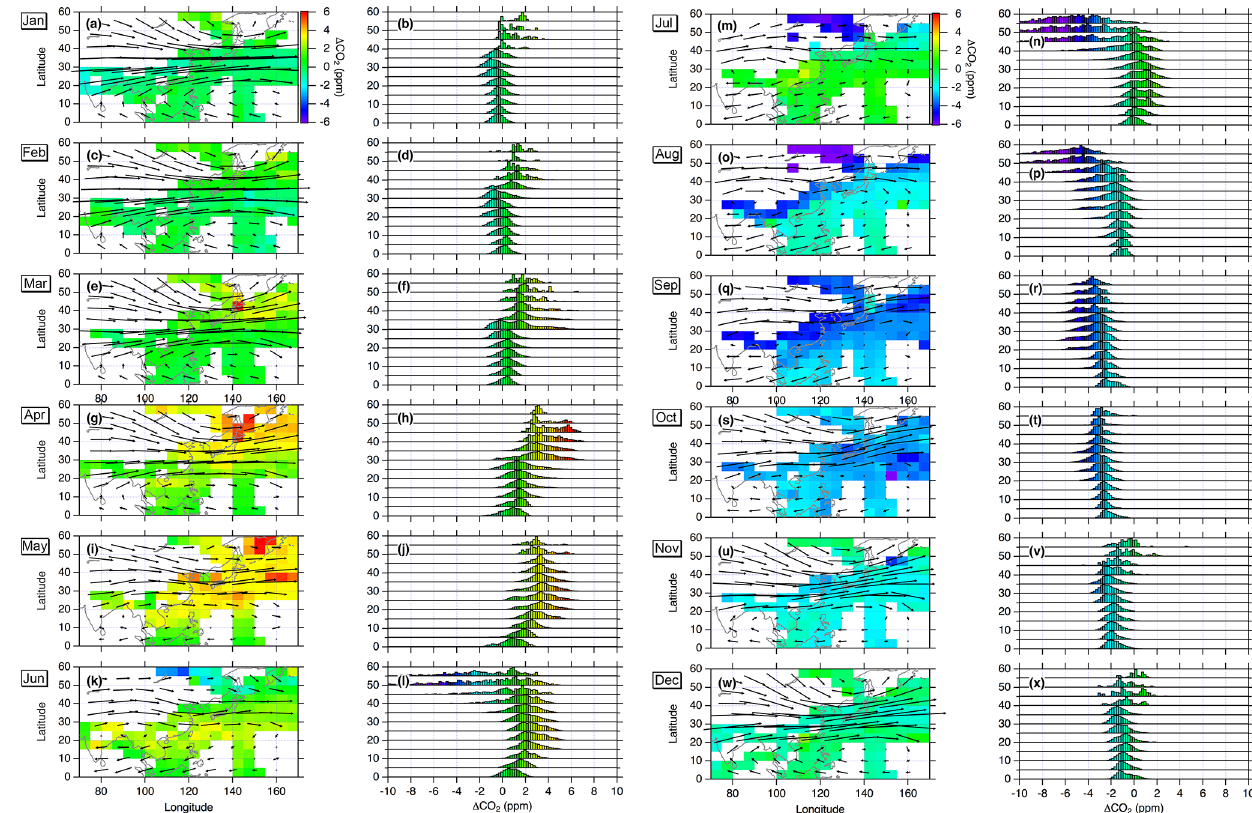
Figure 3. (Left) Monthly climatological CO 2 mole fraction ( (cid:49) CO 2 ) in the UT over the Asia-Pacific region. The CO 2 data taken at altitudes > 8km are averaged in each 5 ◦ × 5 ◦ bin. The CO 2 data influenced by stratospheric air (PV > 2PVU) were excluded. Also shown are monthly averaged wind vectors at 250hPa from the JCDAS/JRA-55 reanalysis data (averaged for the observation years). (Right) Histograms of (cid:49) CO 2 in each 5 ◦ latitude bands color coded in the same manner as in the left panels. Every histogram is normalized by maximum